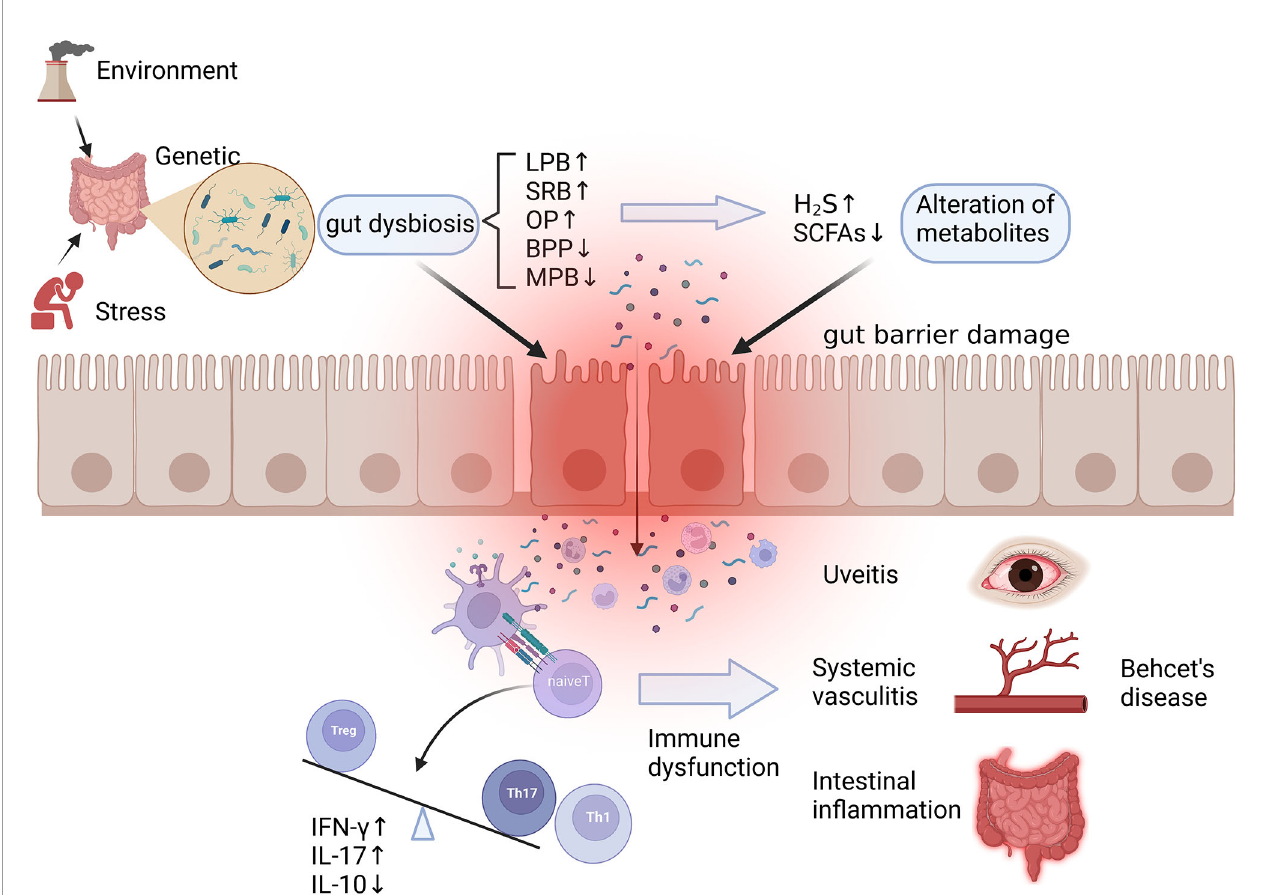
FIGURE 2 | Potential mechanism of dysbiosis of gut microbiota in the pathogenesis of Behcet ’ s disease. Gut dysbiosis caused by environmental, stress, and genetic factors manifests as an increase in LPB, SRB, and OP and a decrease in BPB and MPB, resulting in alteration of microbial metabolites such as SCFAs and H2S. The above changes lead to the damage of the intestinal mucosal barrier, the invasion of microorganisms, and the leakage of their metabolites, which contribute to immune dysfunction such as overactivation of innate immune, increased differentiation of Th1 and Th17, and imbalance of Th17/Treg, ultimately helping the development of autoimmune reactions and systemic vasculitis. LPB, lactate-producing bacteria; SRB, sulfate-reducing bacteria; OP, opportunistic pathogen; BPB, butyrate-producing bacteria; MPB, methanogens; SCFAs, short chain fatty acids. Created with